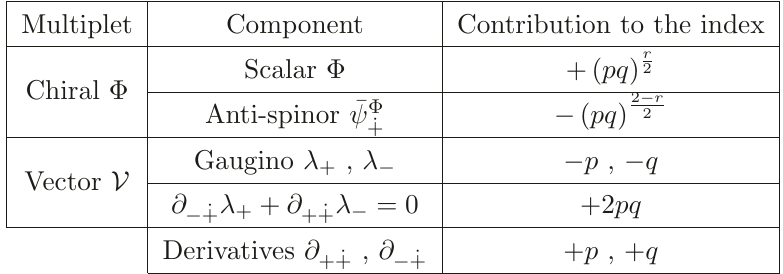
Table 2 . The various ingredients that have a nonvanishing contribution to the index. In this table, r is the IR R charge of Φ, and the characters corresponding to gauge and global symmetries are suppressed (e.g. the gaugino is always in the adjoint of the gauge group, and thus its contribution will include the corresponding